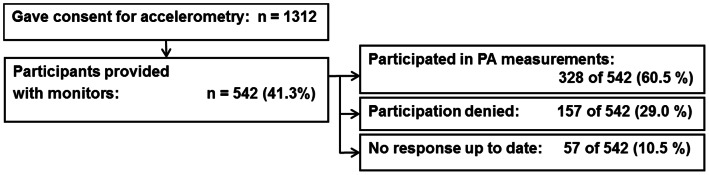
Response rate to accelerometry in the ongoing GINIplus study (date: June 2012).